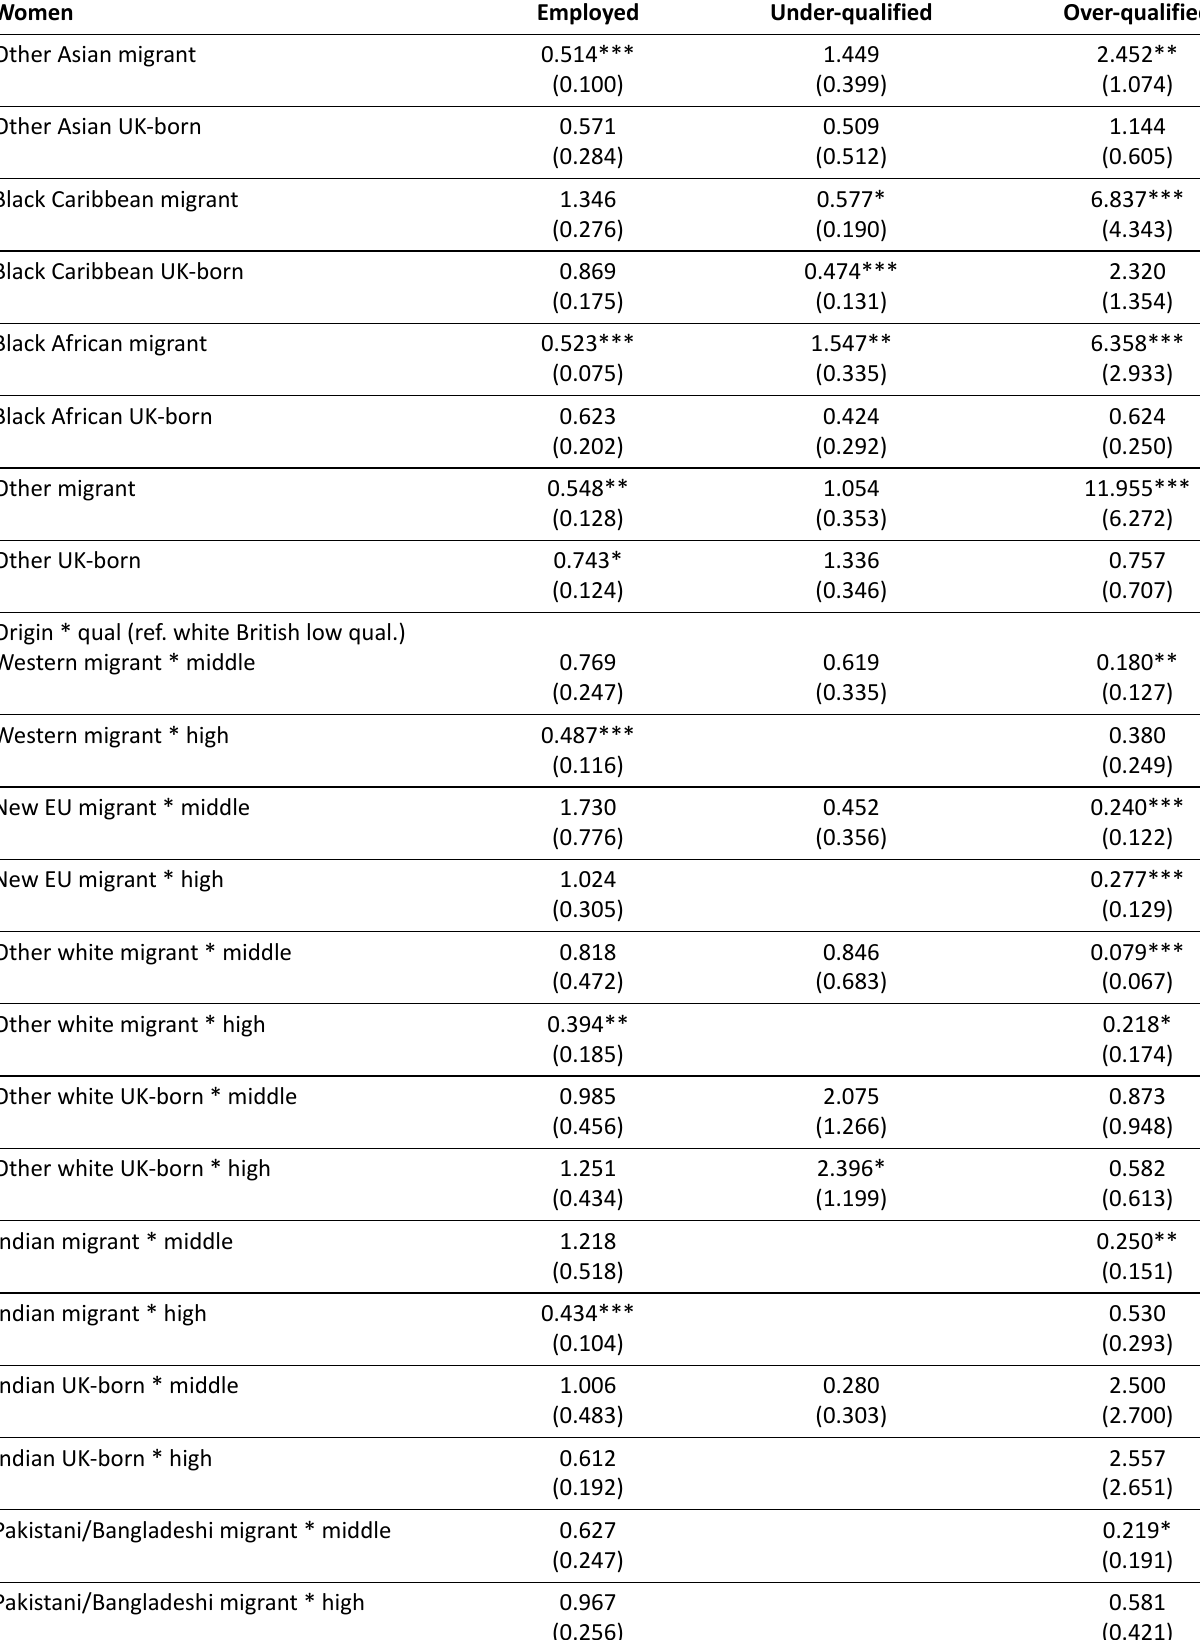
Table A4. (Cont.) Binary logistic regression model (odds ratio) of employment, under- and over-qualification for